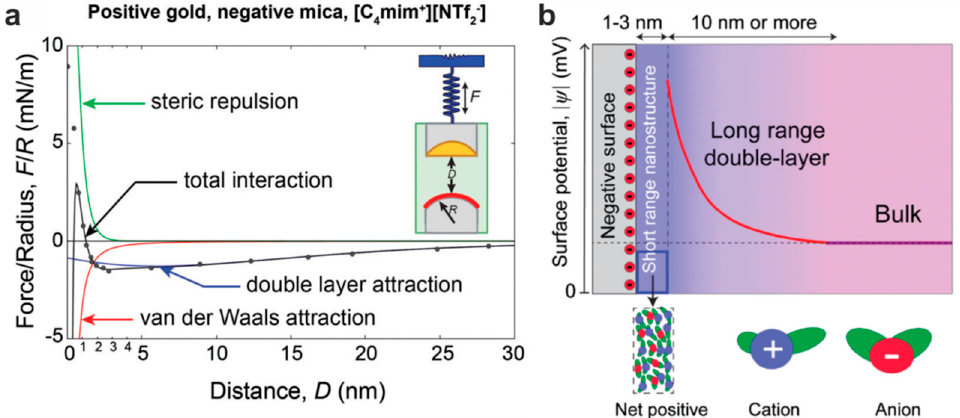
Figure 6. ( a ) SFA measurement of [C 4 MIm] [NTf 2 ] sandwiched between Au and mica; ( b ) resulting model of the electric double layer. Adapted from Gebbie et al. [61].